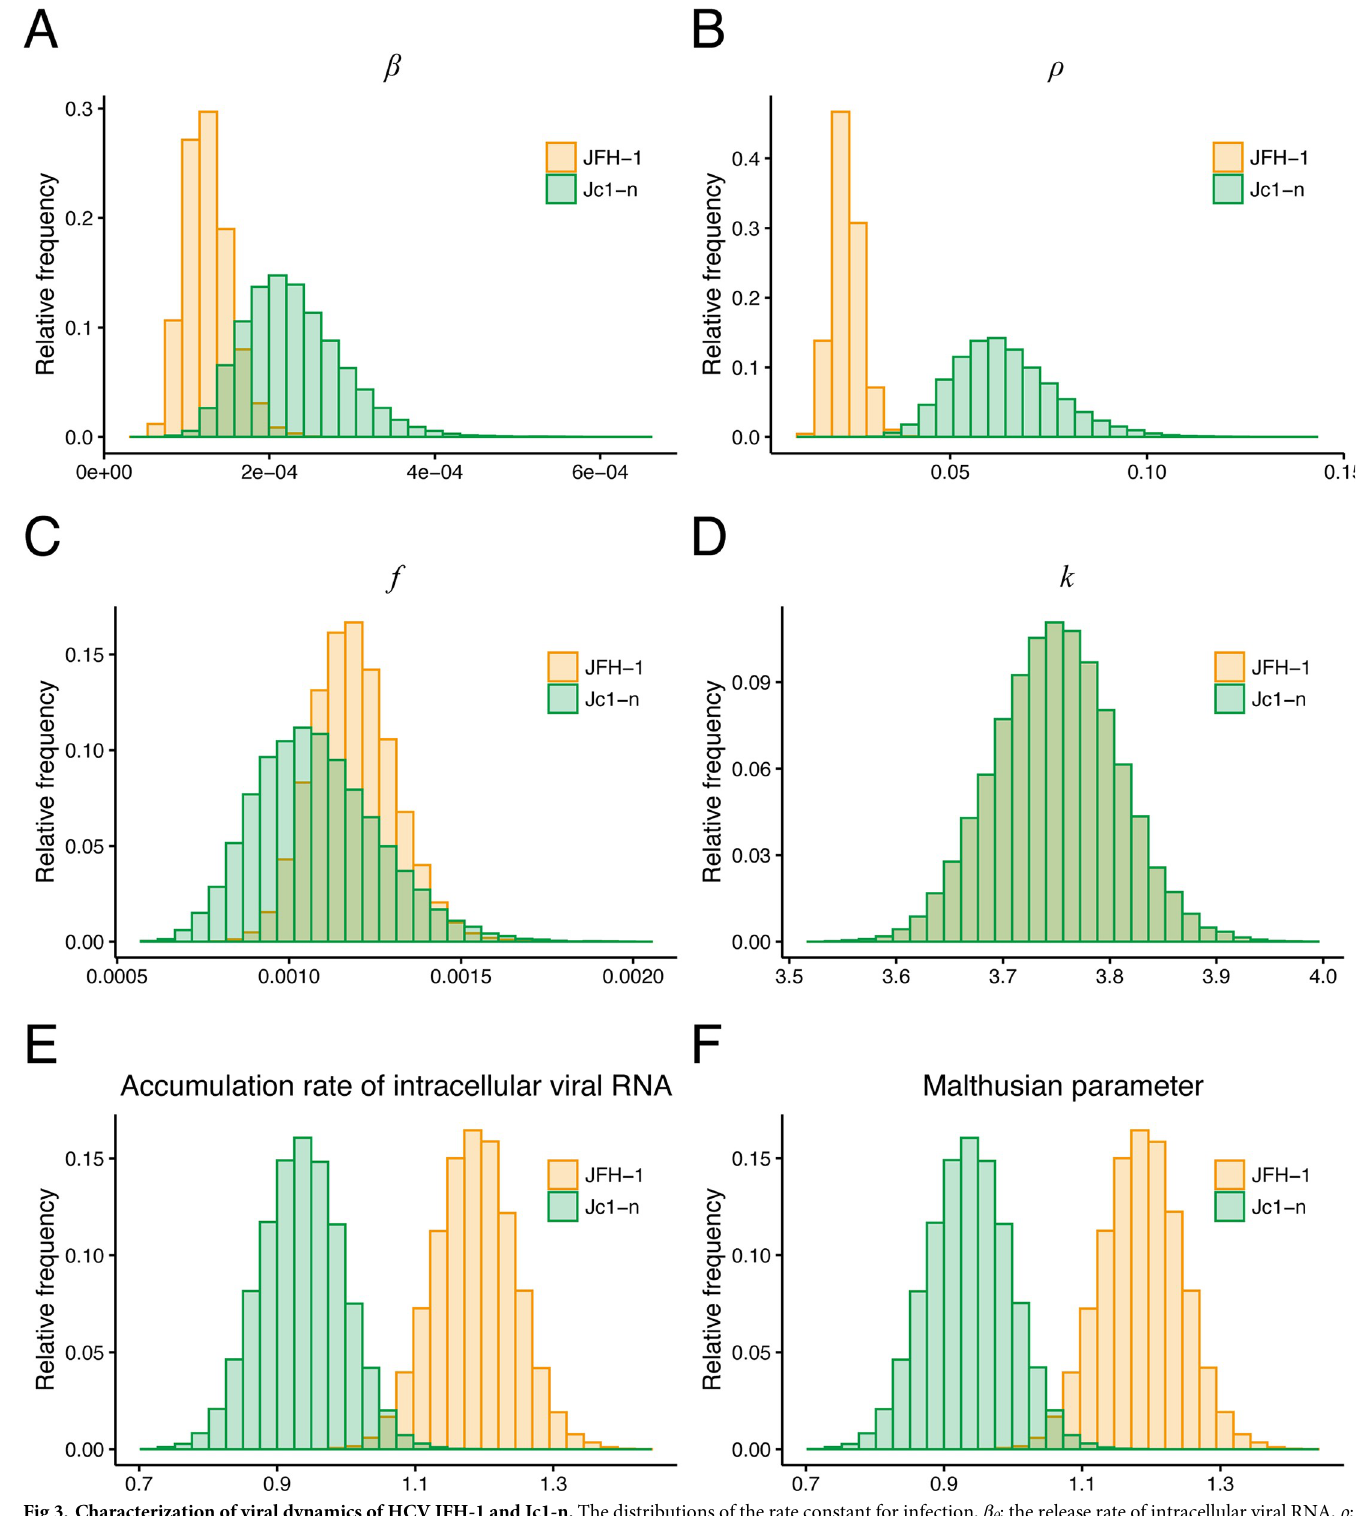
Fig 3. Characterization of viral dynamics of HCV JFH-1 and Jc1-n. The distributions of the rate constant for infection, β θ ; the release rate of intracellular viral RNA, ρ ; the converted fraction of infectious viral RNA, f ; and the replication rate of intracellular viral RNA, k , inferred by MCMC computations are shown in (A) , (B) , (C) and θ (D) , respectively, for HCV JFH-1 (orange) and Jc1-n (green). Parameters β θ and ρ for Jc1-n were significantly larger than for JFH-1, whereas there was no significant